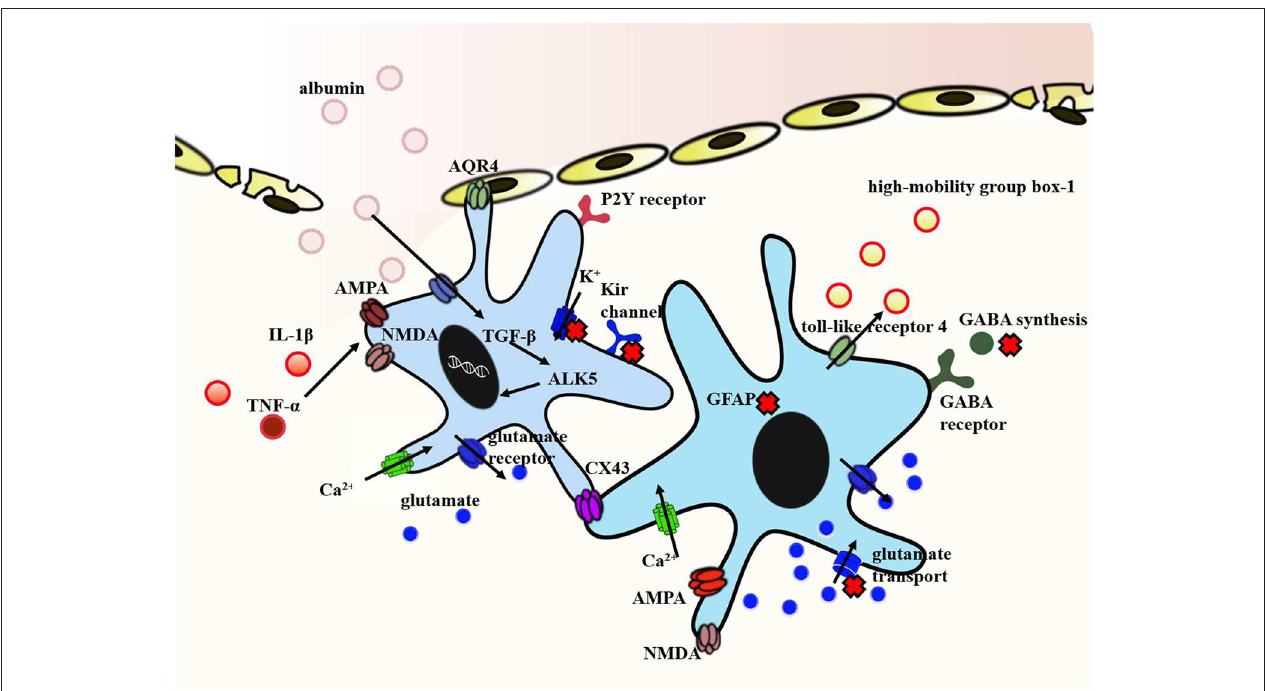
FIGURE 2 | Representative molecular mechanism of post-traumatic epilepsy involved in astrocytes. The exposure of brain tissue to extravasated serum albumin induces activation of TGF- β /ALK5 signaling in astrocytes. IL-1 β and TNF α implicated in NMDA and AMPA receptor activation inducing Ca 2 + influx in a dose-dependent manner. In addition, IL-1 β and TNF α down-regulate the expression of Kir channels and weaken its clearance of extracellular K + . Decreased expression of Kir channels in concert with dislocation of AQP4 channels in astrocytes contribute to impaired K + buffering. In this context, reactive astrocytes dramatically transform in their morphology and function. Reactive astrocyte is characterized by the proliferation of astrocytes and the hallmark accumulation of GFAP. Traumatic brain injury also causes a deranged glutamate uptake and a decreased GABA release. The high-mobility group box-1 is an additional inflammatory agent produced by reactive astrocytes and mediated by the toll-like receptor 4. Finally, the expression of Cx43 protein is different in human and animal. It is generally shown to be increased in human, whereas findings from animal models are conflicting. Arrows show the flow direction. The red forks represent the disordered functions. Some mechanisms are indicated by abbreviations. GFAP, glial fibrillary acidic protein; NMDA, N-methyl-D-aspartate; AMPA, a-amino-3-hydroxy-5-methyl-4-isoxazolepropionic acid; GABA, γ -aminobutyric acid; AQP4, aquaporin-4; TGF- β , transforming growth factor- β ; Cx43, connexin-43; IL-1 β ,